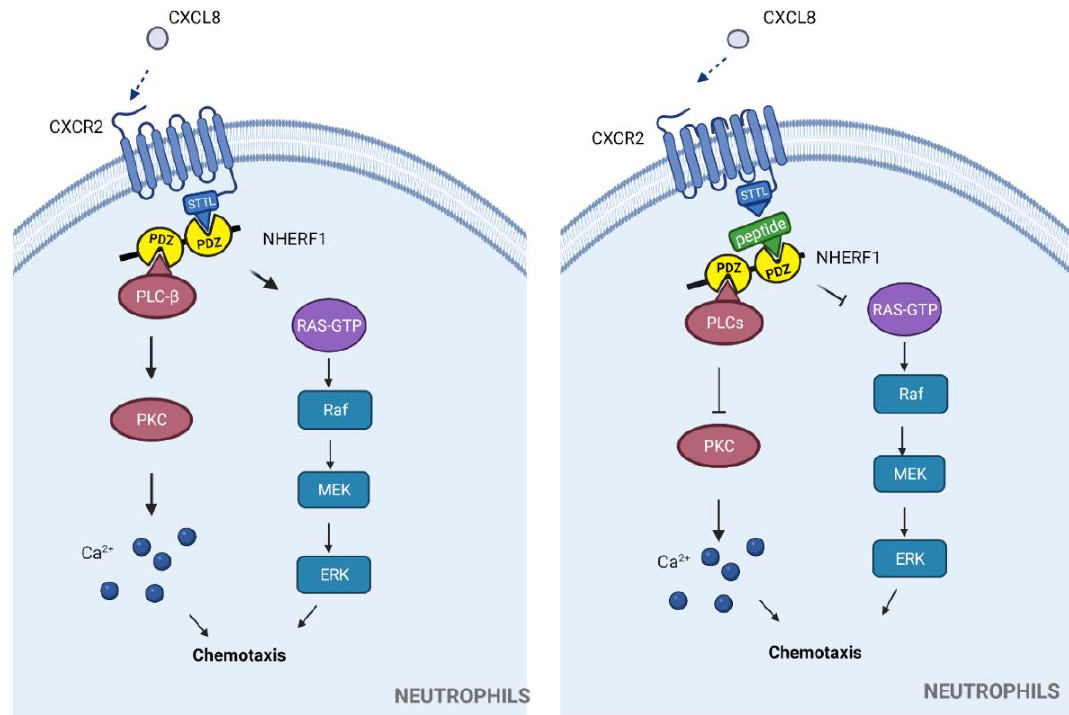
Figure 2. PDZ-dependent interaction of CXCR2 with NHERF1 is required for neutrophil functions. In response to the chemokine CXCL8, NHERF1 organizes a tripartite complex through recognition of the PDZbm STTL of CXCR2 and PLC- β , whose downstream signaling leads to neutrophil calcium mobilization and chemotaxis (left). Disruption of this complex by exogenously added peptide corresponding to the last 13 aa of CXCR2 inhibits these neutrophil functions (right).